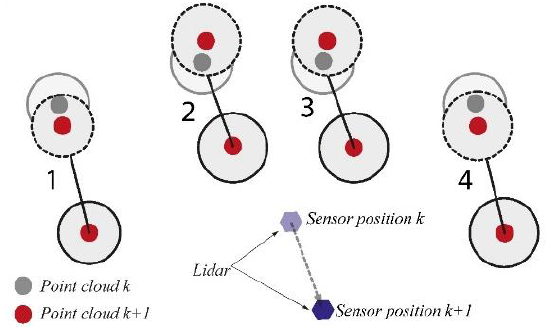
Figure 8. A graphic presentation the corrected position using the sums of mean errors CEP (circular error probable) calculated for the matched points.